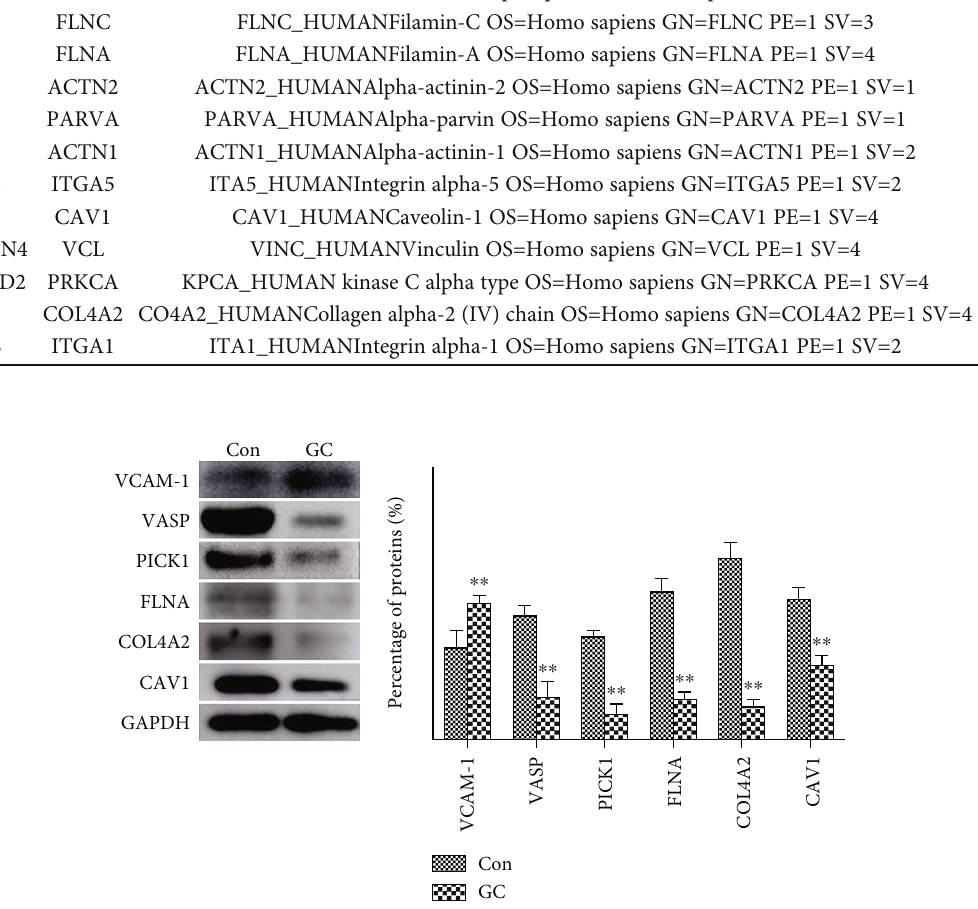
Figure 4: Western blotting was performed to measure the levels of VCAM1, FLNA, VASP, CAV1, PICK1, and COL4A2 in GC and adjacent normal tissues. ∗∗ P < 0 : 01 .